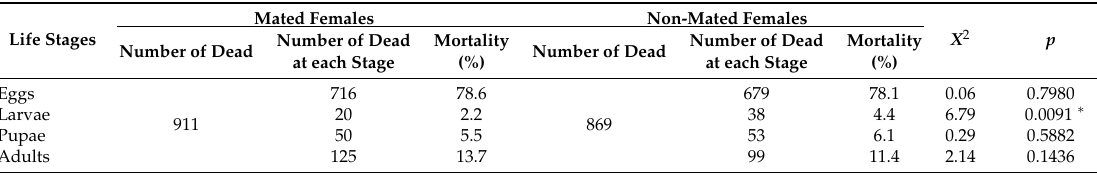
Table 3. Parasitism failure: percentage of mortality during development of Ooencyrtus lucidus on Bagrada hilaris